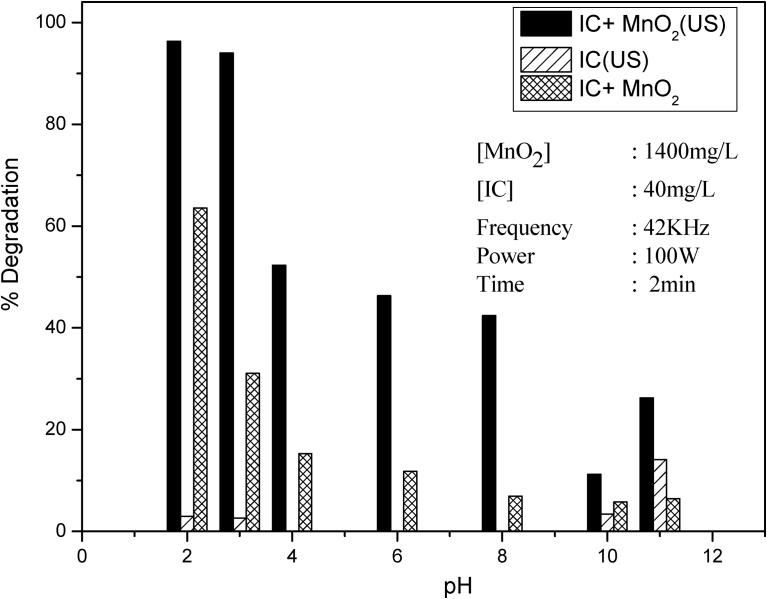
Effect of pH on the sonocatalytic degradation of IC in the presence and absence of MnO2.